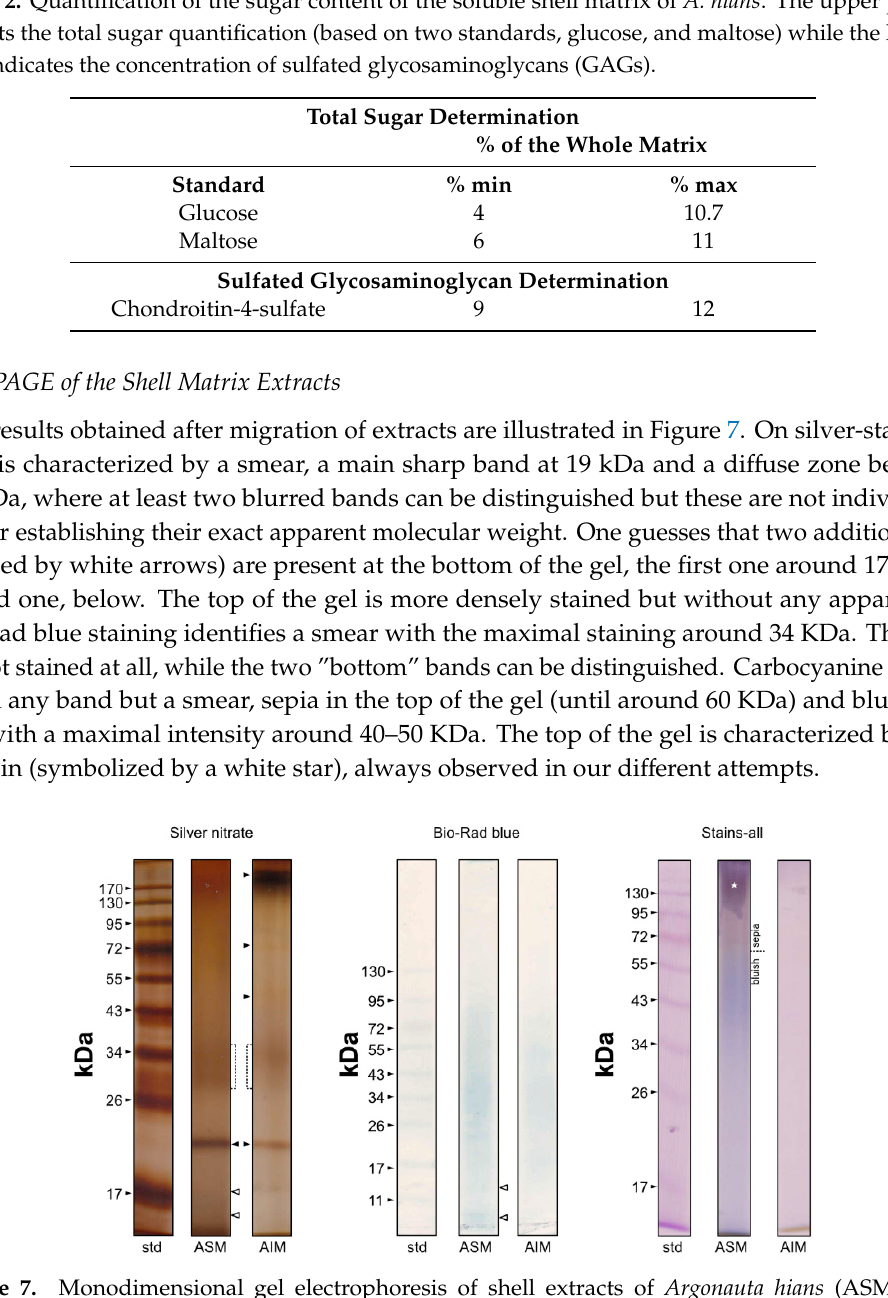
Figure 7. Monodimensional gel electrophoresis of shell extracts of Argonauta hians (ASM and Laemmli-soluble AIM). Silver nitrate ( left ), Bio-Rad Blue ( middle ) and carbocyanine ( right ) staining were applied. The arrows point out discrete bands while the white star indicates the slimy purple stain obtained with carbocyanine on ASM.